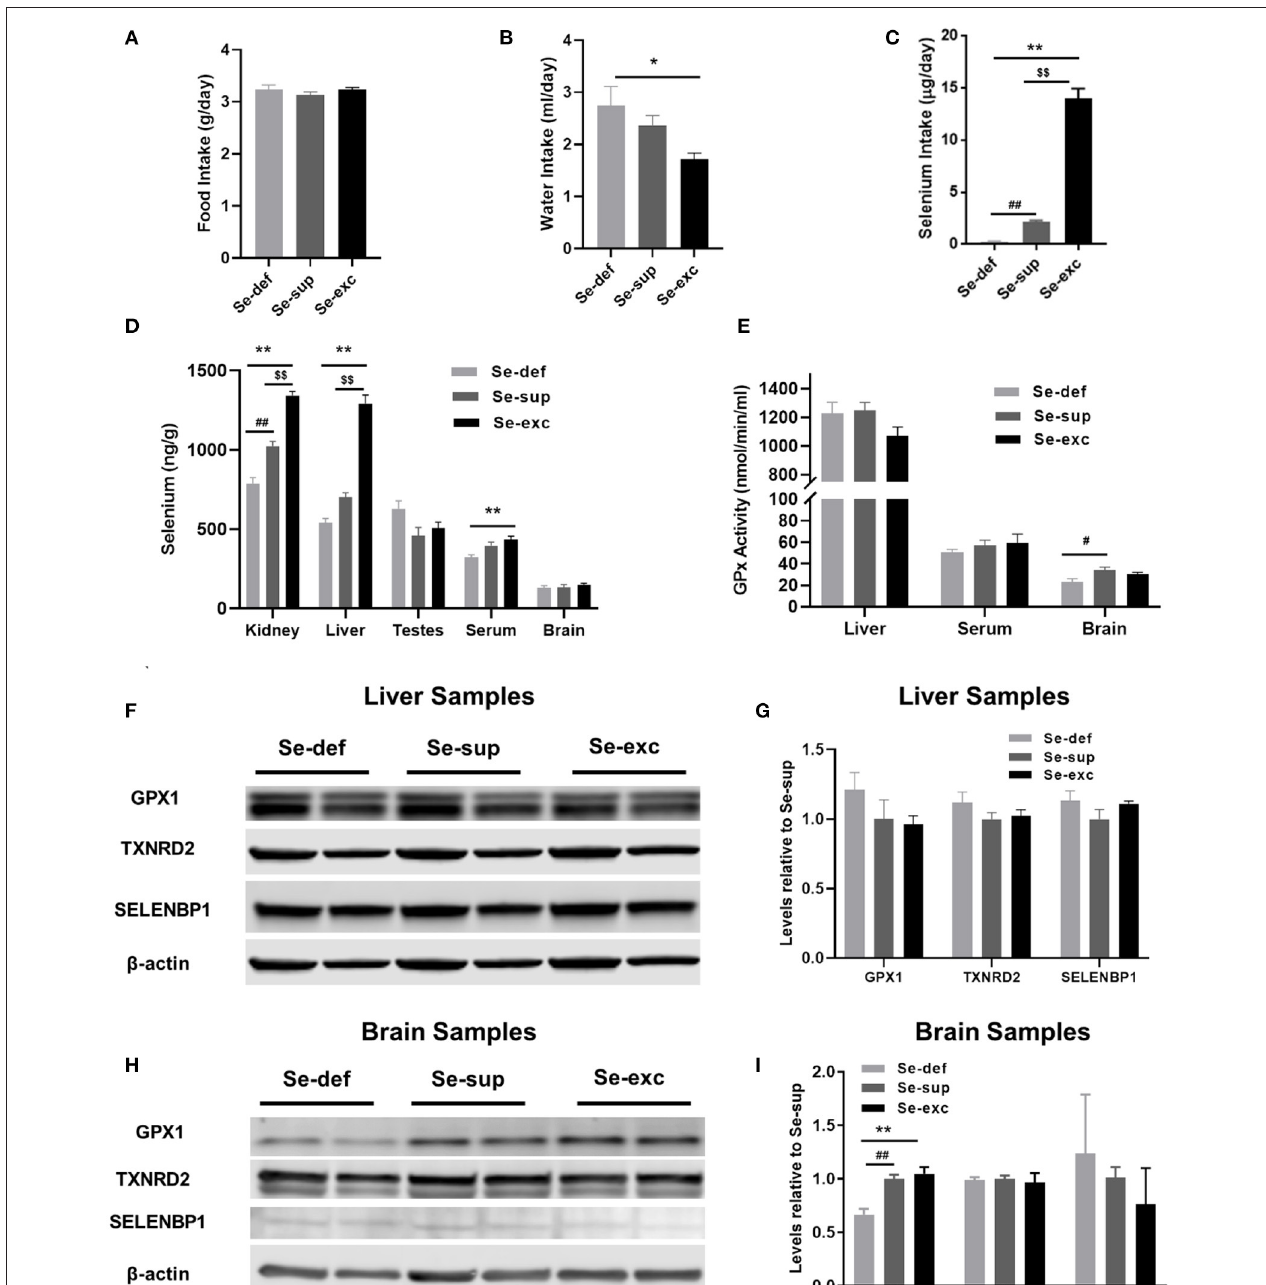
FIGURE 1 | Assessment of varying Se supplementation on organ-specific Se content, glutathione peroxidase activity, and selenoprotein levels. (A) Mean ( ± SEM) daily food intake. (B) Mean ( ± SEM) daily water consumption. (C) Mean ( ± SEM) daily selenium intake ( n = 6–7 per group). (D) Mean ( ± SEM) selenium content in kidney, liver, testes, serum, and brain ( n = 3–4 per group). (E) Mean ( ± SEM) GPX activity in liver, serum, and brain ( n = 4 – 6). (F–I) Protein levels of GPX1, TXNRD2, and SELENBP1 in liver (F,G) and brain (H,I) ( n = 4). $$ p < 0.01 between Se-exc and Se-sup groups; * p < 0.05 between Se-exc and Se-def groups; ** p < 0.01 between Se-exc and Se-def groups; # p < 0.05 between Se-def and Se-sup groups; ## p < 0.01 between Se-def and Se-sup groups.